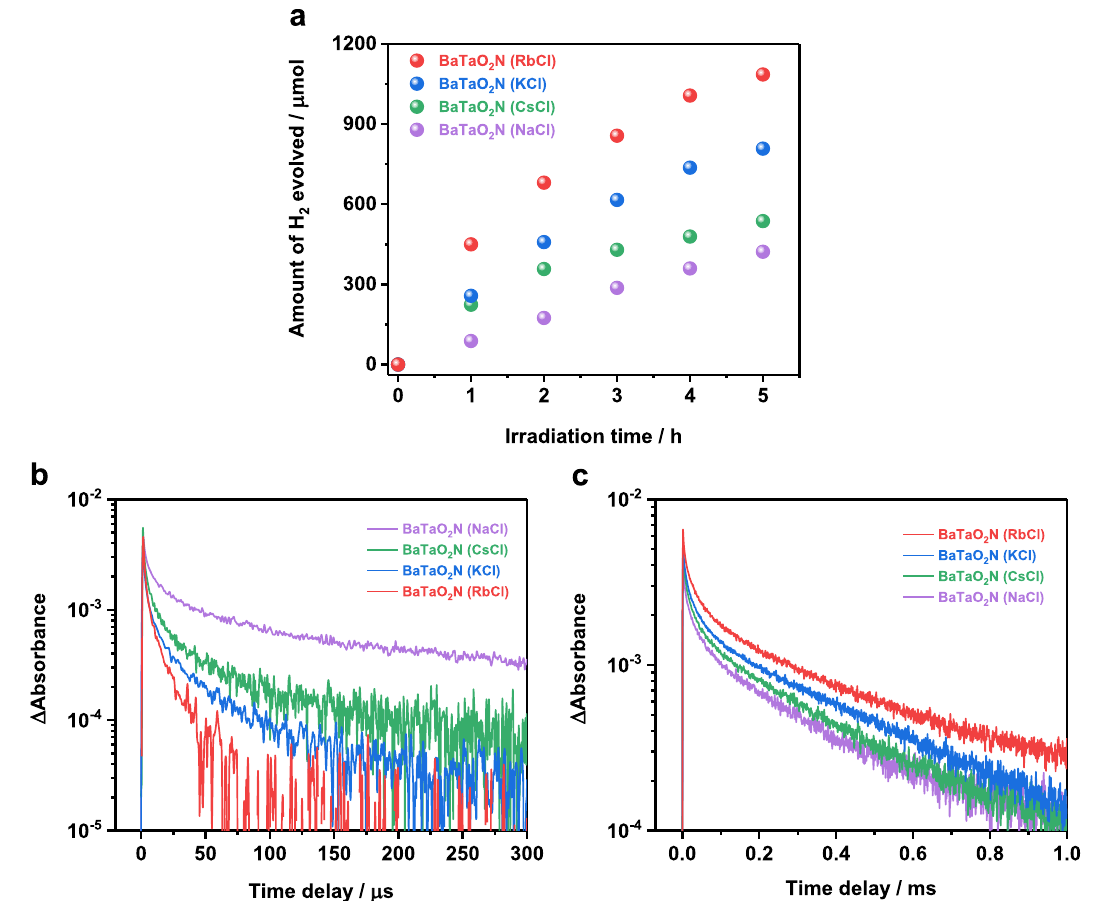
Fig. 4 Photocatalytic H 2 evolution and photoexcited charge dynamics of Pt-modi fi ed BaTaO 2 N photocatalysts. a Photocatalytic performance of H 2 evolution on different Pt-modi fi ed BaTaO 2 N photocatalysts from an aqueous methanol solution. Conditions: Pt-modi fi ed BaTaO 2 N photocatalyst, 0.1g; cocatalyst, 0.3wt% in total (sequential decoration method: 0.1wt% by impregnation – reduction and 0.2wt% by photodeposition); 10vol% aqueous methanol solution, 150mL; light source, 300W Xenon lamp equipped with a cut-off fi lter ( λ ≥ 420nm); reaction system, Pyrex top-illuminated vessel connected to the closed gas-circulation system without evacuation of gas products. b , c Transient absorption decays corresponding to electron dynamics ( b ) and hole dynamics ( c ) in different Pt-modi fi ed BaTaO 2 N photocatalysts probed at 11000cm − 1 (910nm, 1.36eV) and 15400cm − 1 (649nm, 1.91eV),